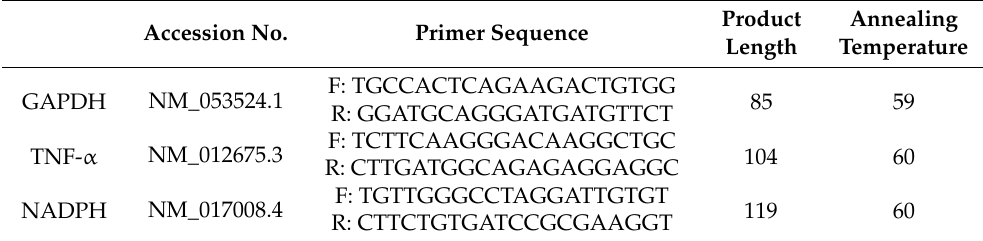
Table 1. Primer sequence and annealing temperature of investigated